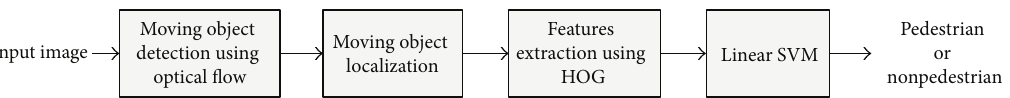
Figure 1: The overview of the pedestrian detection algorithm.